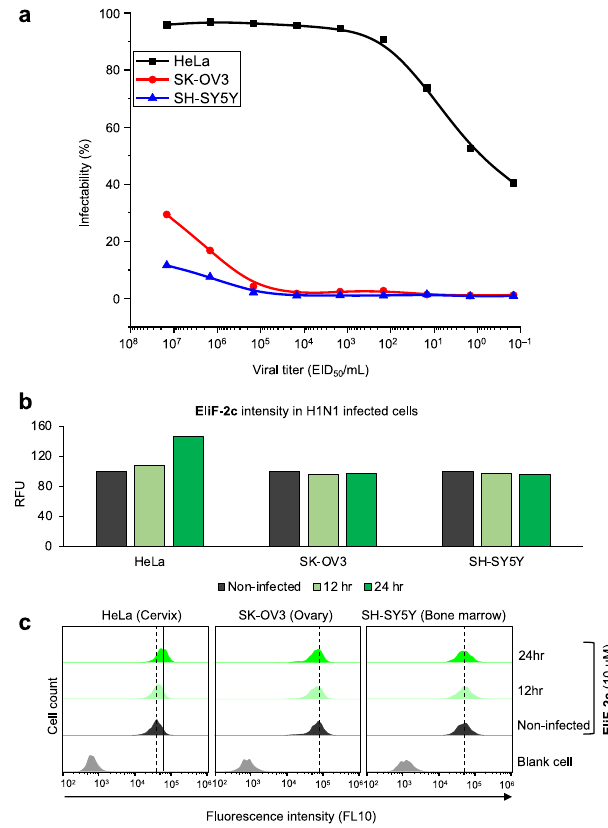
Fig. 8 | Response to H1N1 AI infection. a H1N1 virus infectability in HeLa (black), SK-OV3 (red), and SH-SY5Y (blue) cells after 24h. b Bar graphs showing the mean fl uorescence intensity of EliF-2c with 1.46-fold enhancement in the HeLa cell after 24h infection. a , b Data were representative of two replicate experiments. c Flow cytometryanalysisof EliF-2c (10 µ M)inHeLa,SK-OV3,andSH-SY5YcellsusingFL10 λ fl uorescence fi lter ( λ exc =405nm; em =550/40nm). RFU relative